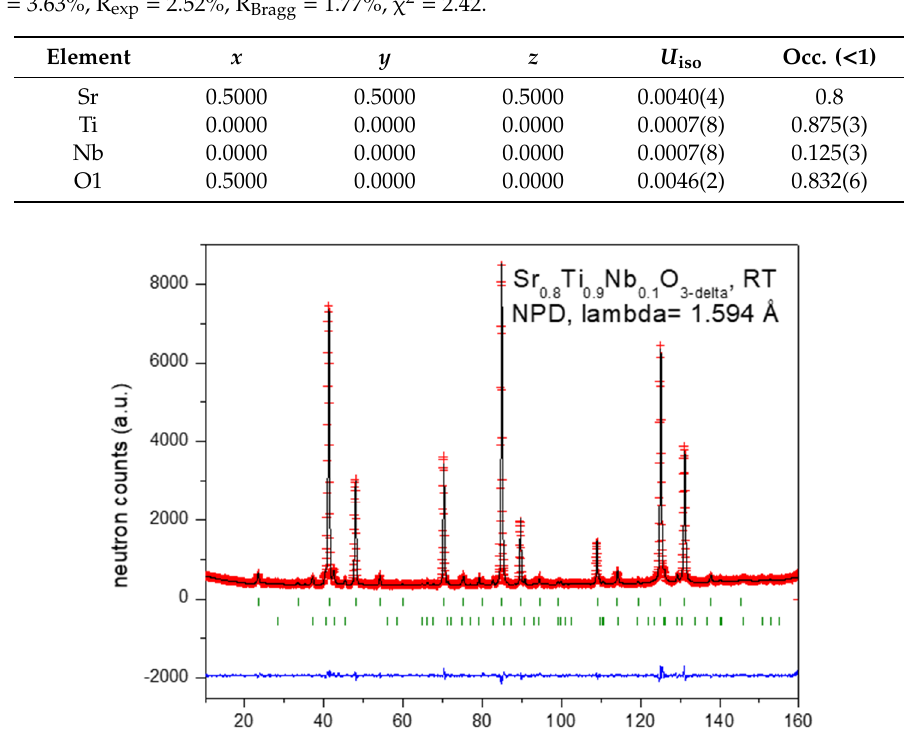
Figure 4. Observed (red crosses), calculated (black line), and difference (lower blue line) NPD profiles for Sr 0.8 (Ti 0.9 Nb 0.1 )O 3−δ at 25 °C. The two series of allowed Bragg positions (green vertical marks) correspond to the main perovskite phase and TiO 2 minor impurity, respectively.